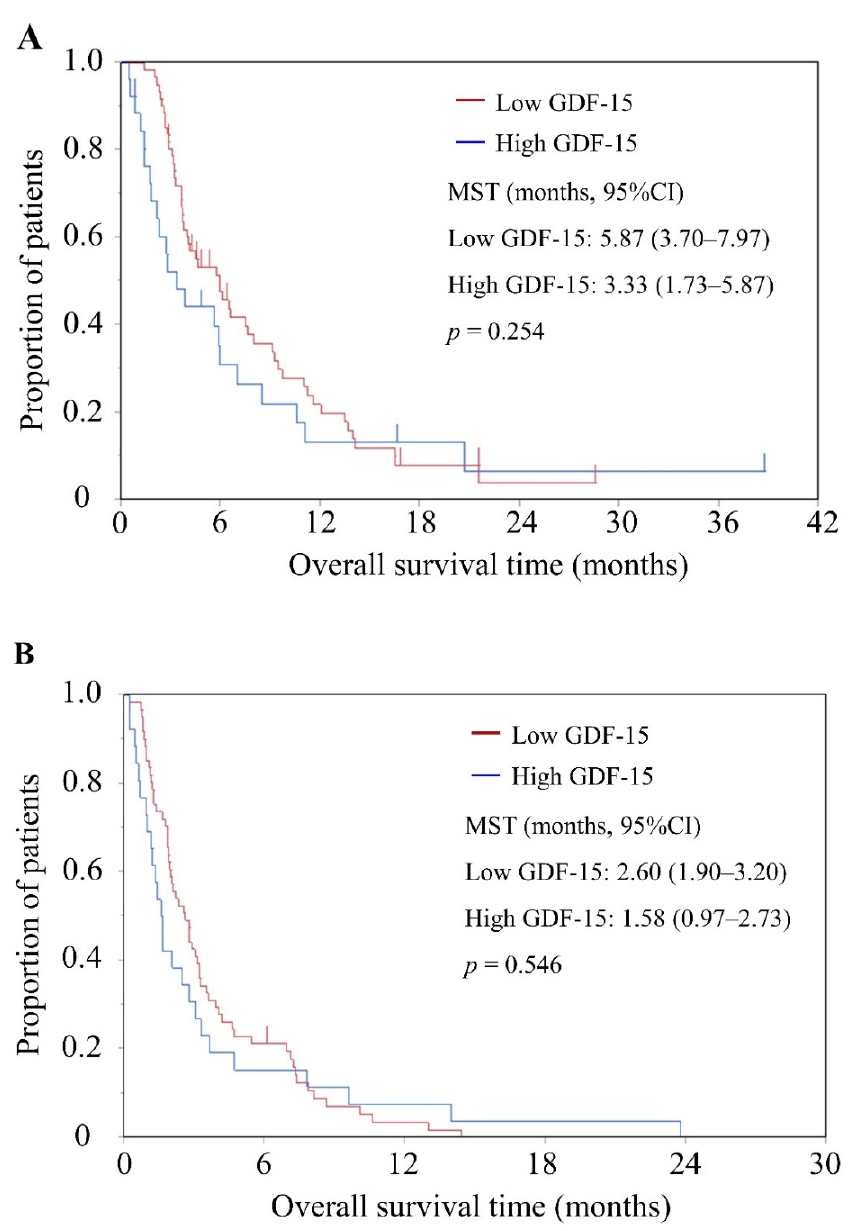
Figure 4. Overall survival (OS) and progression-free survival (PFS) according to high or low serum GDF-15 levels in patients with liver metastasis of APC. Kaplan-Meier plots of ( A ) OS and ( B ) PFS for patients receiving chemotherapy. MST, median survival time.